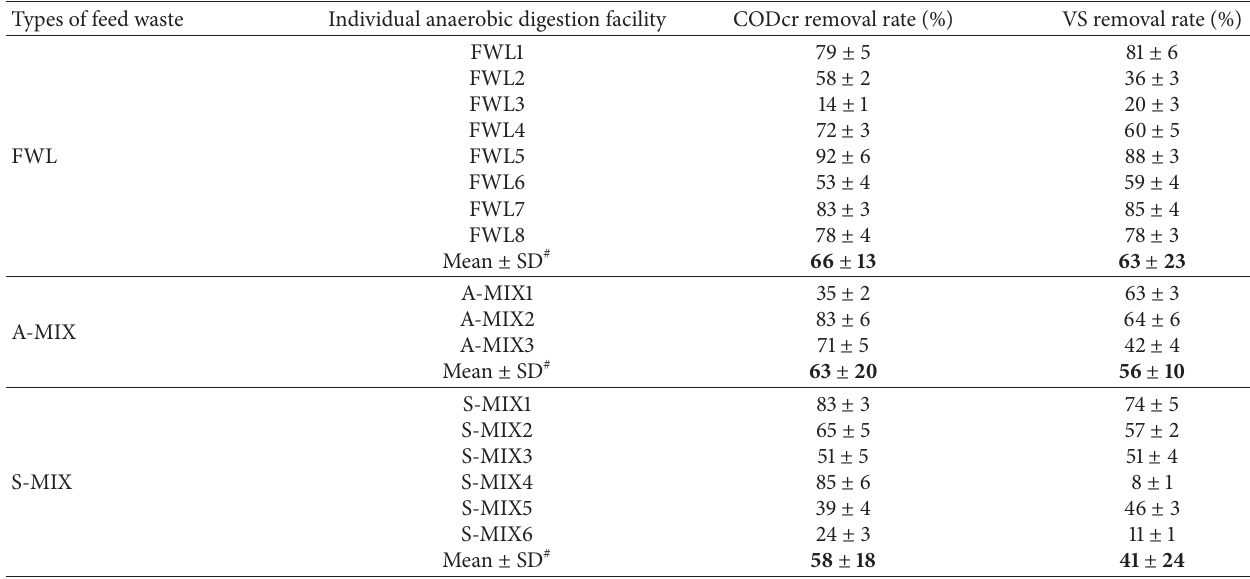
Table 4: Results of COD and VS removal rate.